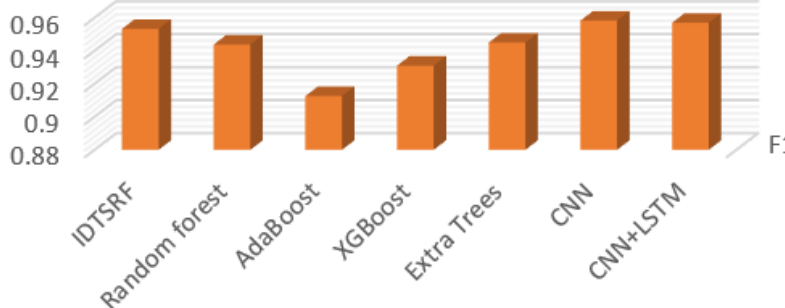
Figure 13. F1 Comparison chart.